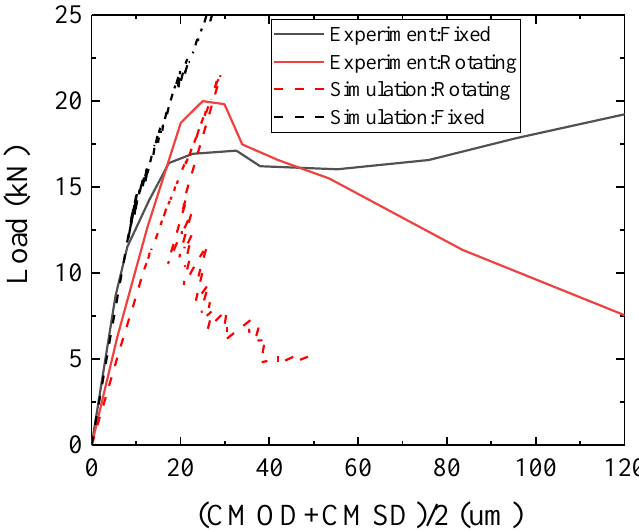
Figure 13. The comparison between the experimental results and numerical results.